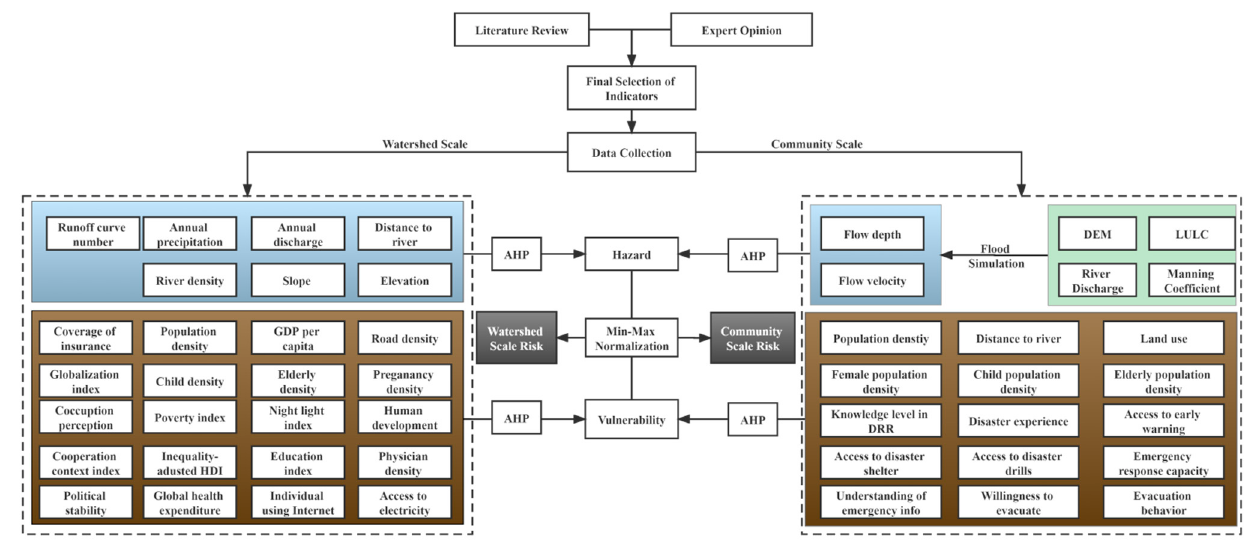
Figure 2. Roadmap of the multiscale risk assessment.